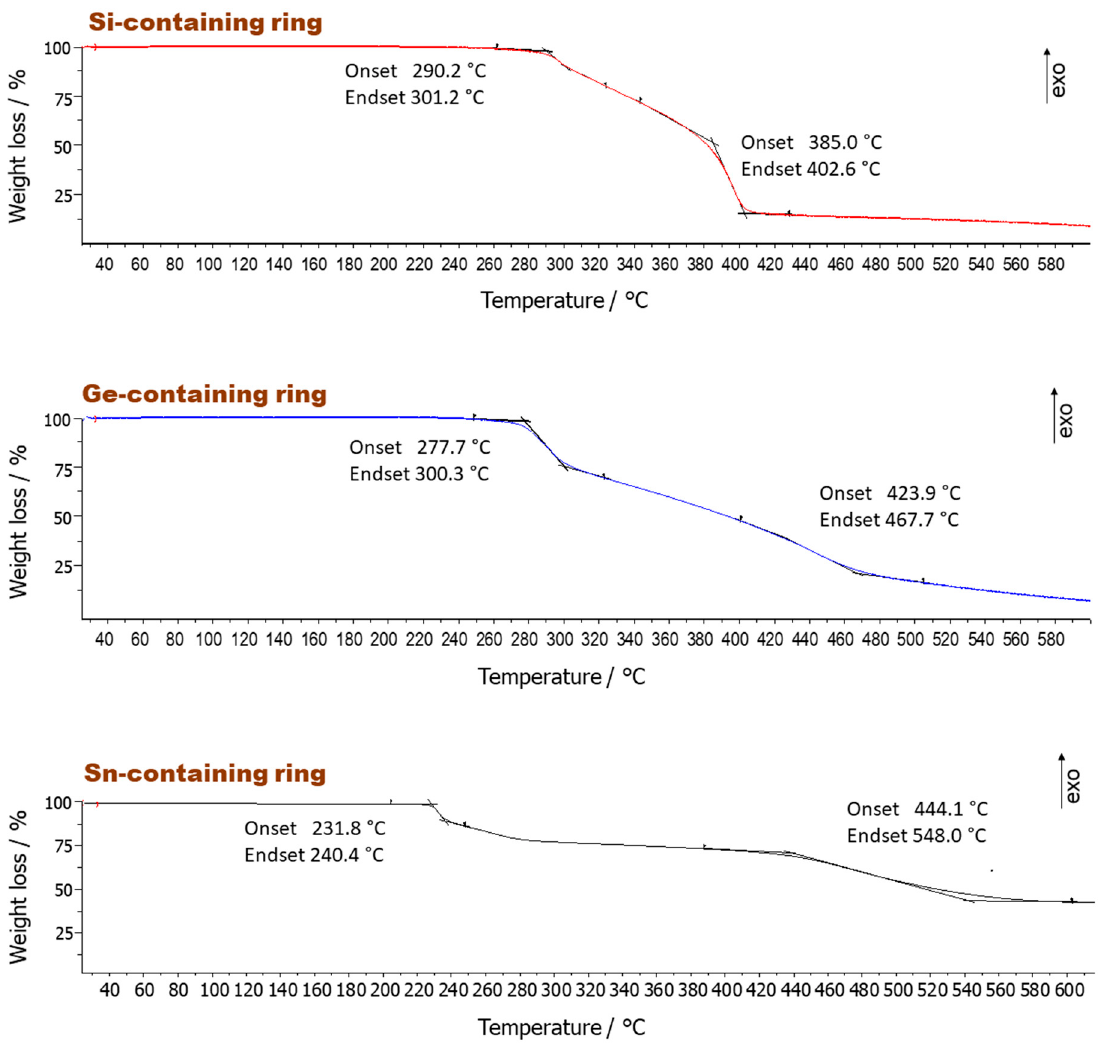
Figure 3. Thermogravimetric analysis (TGA) of the group 14 element ring systems (Si-containing ring 9a , Ge-containing ring 9b , and Sn-containing ring 9c ) at a heating rate of 10 K/min under nitrogen flow of 20 mL/min.